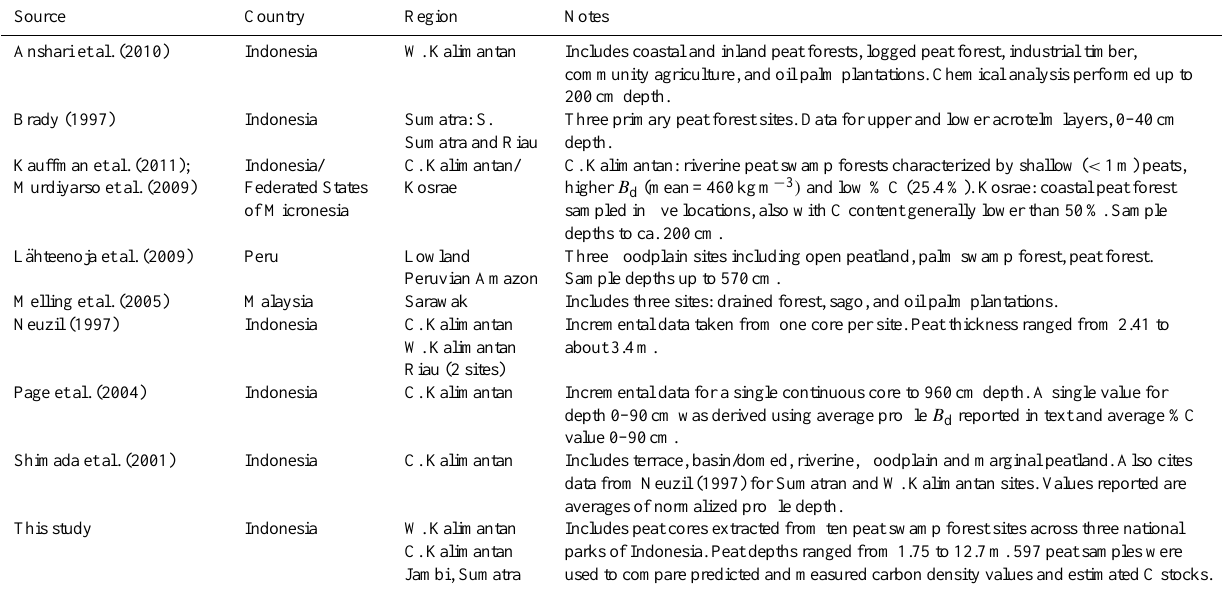
Table 1. Source and locations of data used for this study.